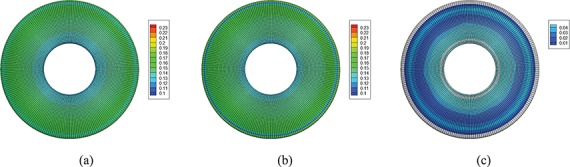
The logarithmic strain generated by (a) IB/FE and (b) ABAQUS. (c) The relative difference (only showing the regions below \documentclass[12pt]{minimal}
\usepackage{amsmath}
\usepackage{wasysym}
\usepackage{amsfonts}
\usepackage{amssymb}
\usepackage{amsbsy}
\usepackage{upgreek}
\usepackage{mathrsfs}
\setlength{\oddsidemargin}{-69pt}
\begin{document}
}{}$5\%$\end{document}).